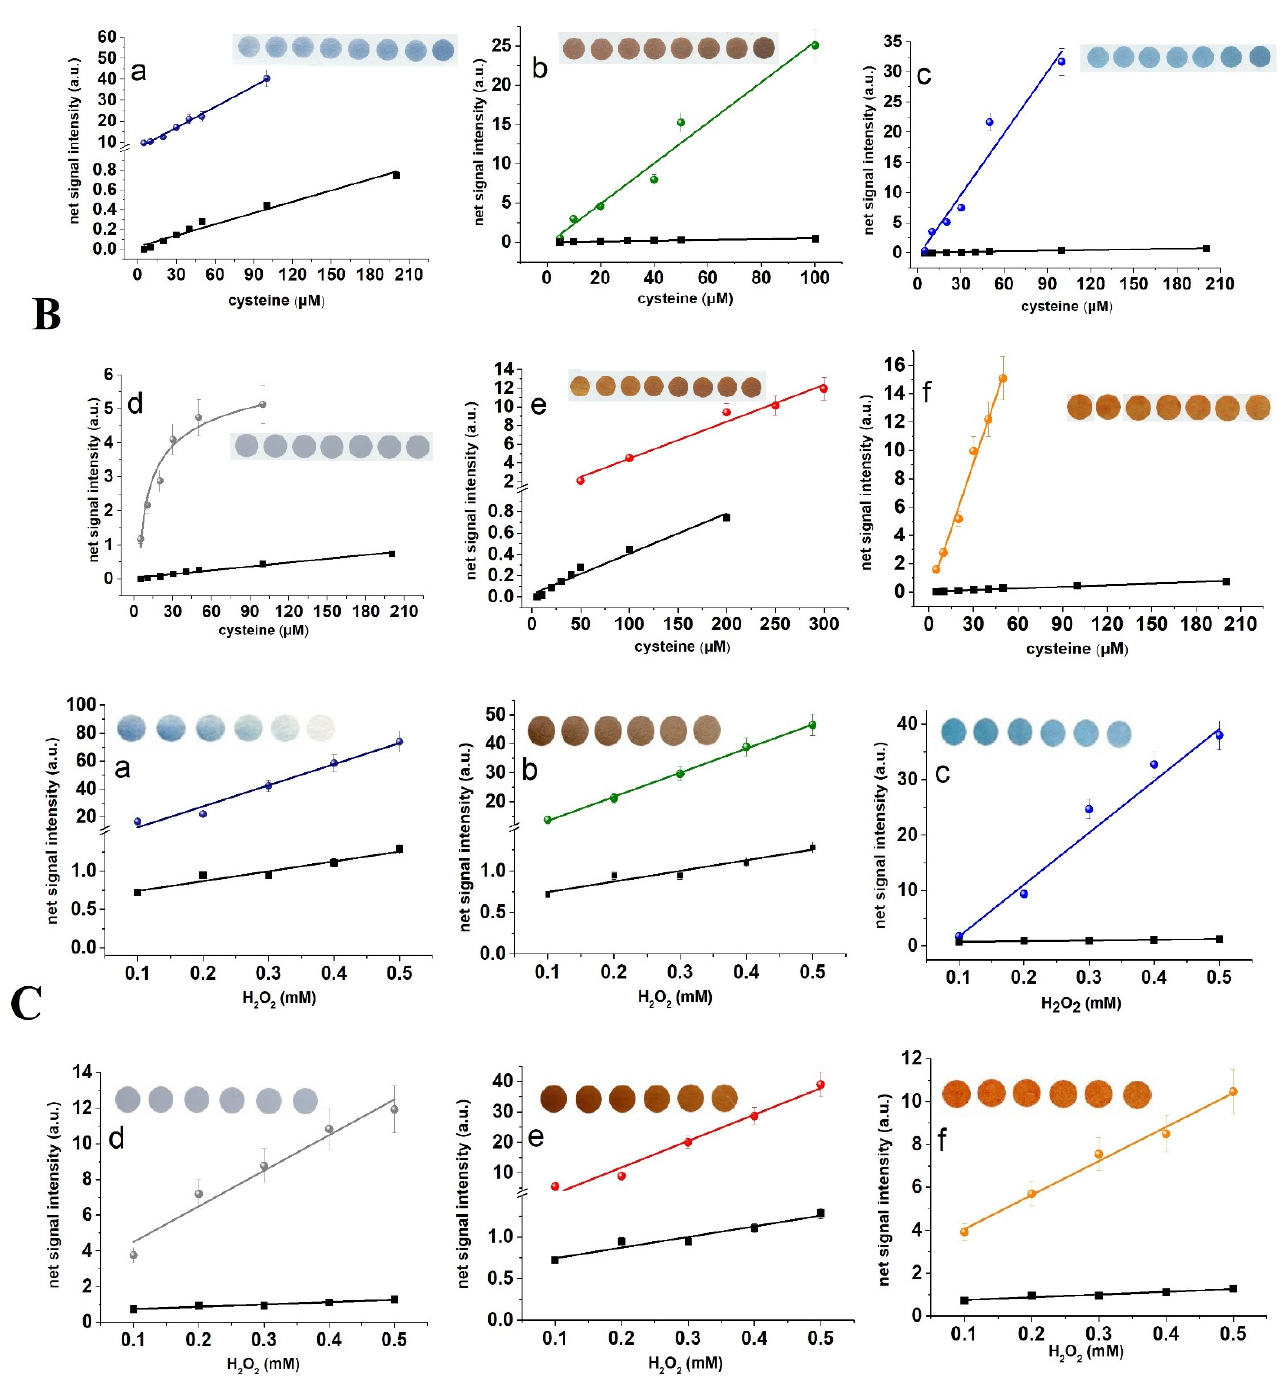
Figure 2. Calibration plots of signal intensity (i.e., net mean grey area intensity) vs. concentration for ( A ) paracetamol at λ = 254 nm, ( B ) Ellman’s reagent at λ = 312 nm, and ( C ) triodide at λ = 365 nm obtained with various photosensitive paper coatings: ( a ) Cyanotype blue, ( b ) salted paper, ( c ) cyanotype green, ( d ) silver halide emulsions, ( e ) can dyke brown, and ( f ) gum dichromate. Each data point corresponds to the mean value of five measurements (in some points the lines used for standard deviations are smaller than the symbols). Embedded photographs show the color transitions with increasing analyte concentrations. In all embedded photographs, the first image (from left to right) is the blank sample. The black line and the square points correspond to the calibration plot obtained with standard